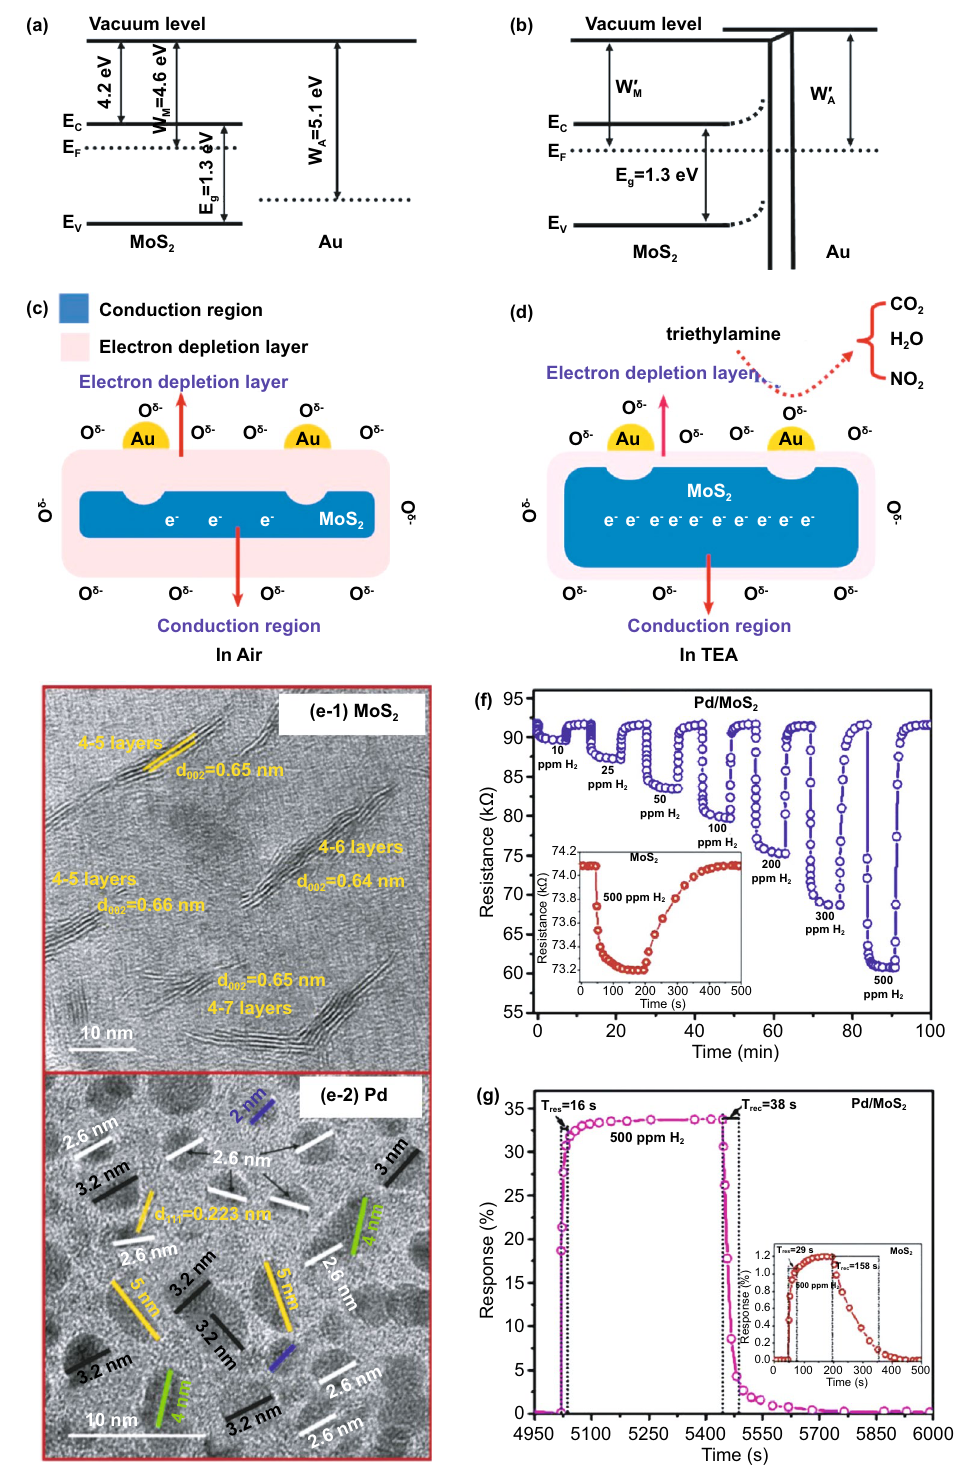
Fig. 14 a Concept map of the energy band configurations for MoS 2 and Au. b Energy band changing of Au@MoS 2 heterojunction. c, d Sche- matic of material before and after gas sensing response. Reprinted with permission from Ref. [208]. Copyright, 2020, Elsevier B.V. HRTEM images of ( e‑1 ) MoS 2 and ( e‑ 2) Pd nanoparticles. f A characteristic response curve (electrical resistance as a function of time) and g the sensor response curve of the Pd/MoS 2 hybrid and the pristine MoS 2 (inset) thin-film sensing devices toward H 2 . The gas sensing measurement was con- ducted at room temperatures. Reprinted from Ref. [212] with permission. Copyright, 2020, Elsevier